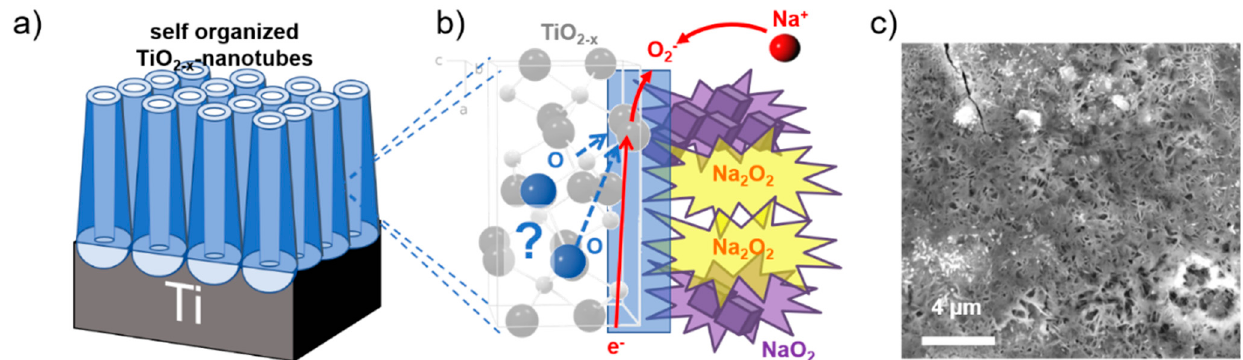
Figure 2. Surface film formation: ( a ) Scheme of the TiO 2 − x NT array and ( b ) the corresponding anatase crystal structure with the proposed reaction of Na-ions and oxygen to sodium peroxide (Na 2 O 2 ) and/or sodium superoxide (NaO 2 ). ( c ) SEM top view image of TiO 2 − x NTs after 230 galvanostatic cycles between 3.0 V and 0.1 V showing the surface coverage after sodiation by an acicular surface film. Reproduced and modified in part with permission from reference [24].